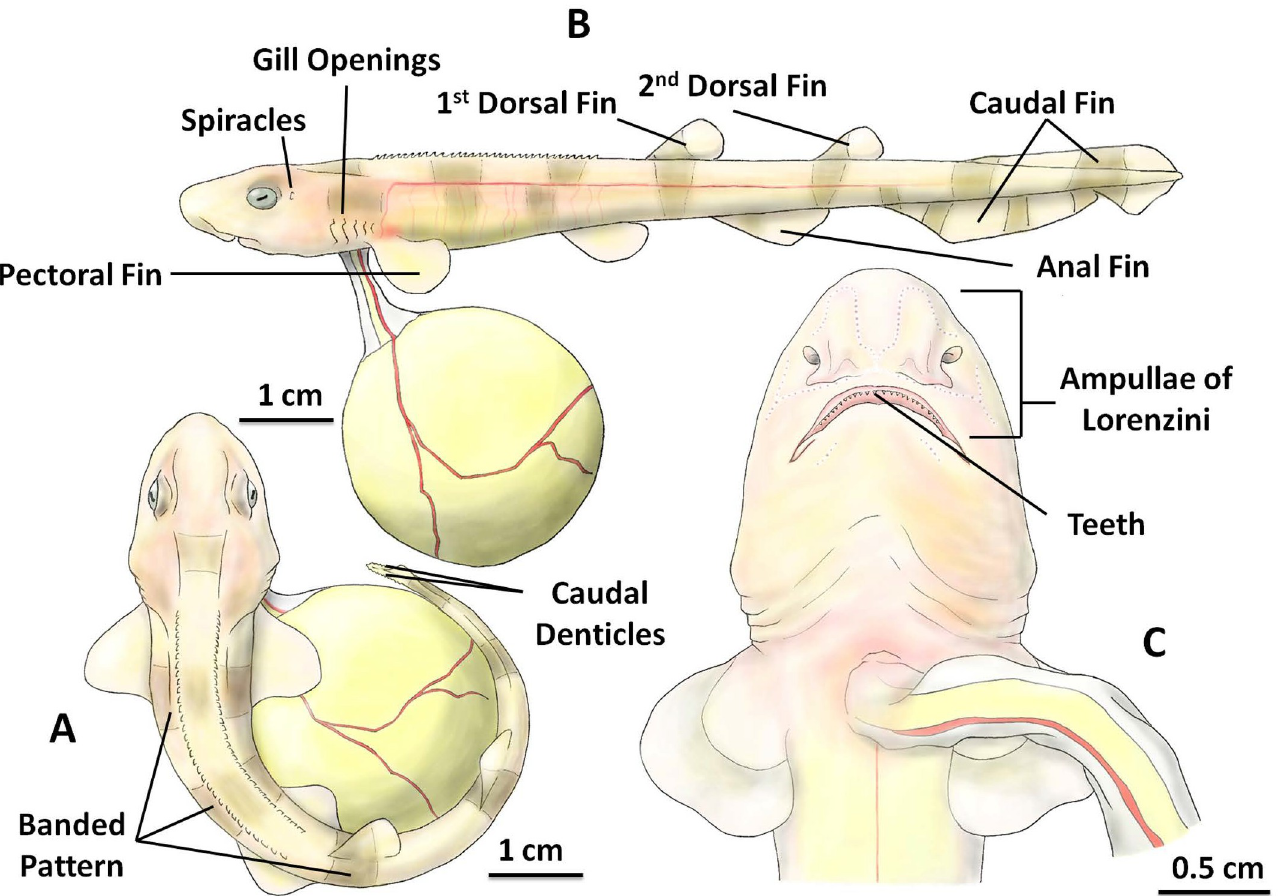
Fig 6. The inside of the S . stellaris egg case at stage 6. A: Position of placoid denticles, caudal denticles and banded patterns on the body (dorsal view). B: A pair of spiracles, five pairs of gill openings, and fins (lateral view). C: The magnified head (ventral view). The key feature for stage 6 was the loss of fin-folds. See S6 File for original photographs of Fig 6